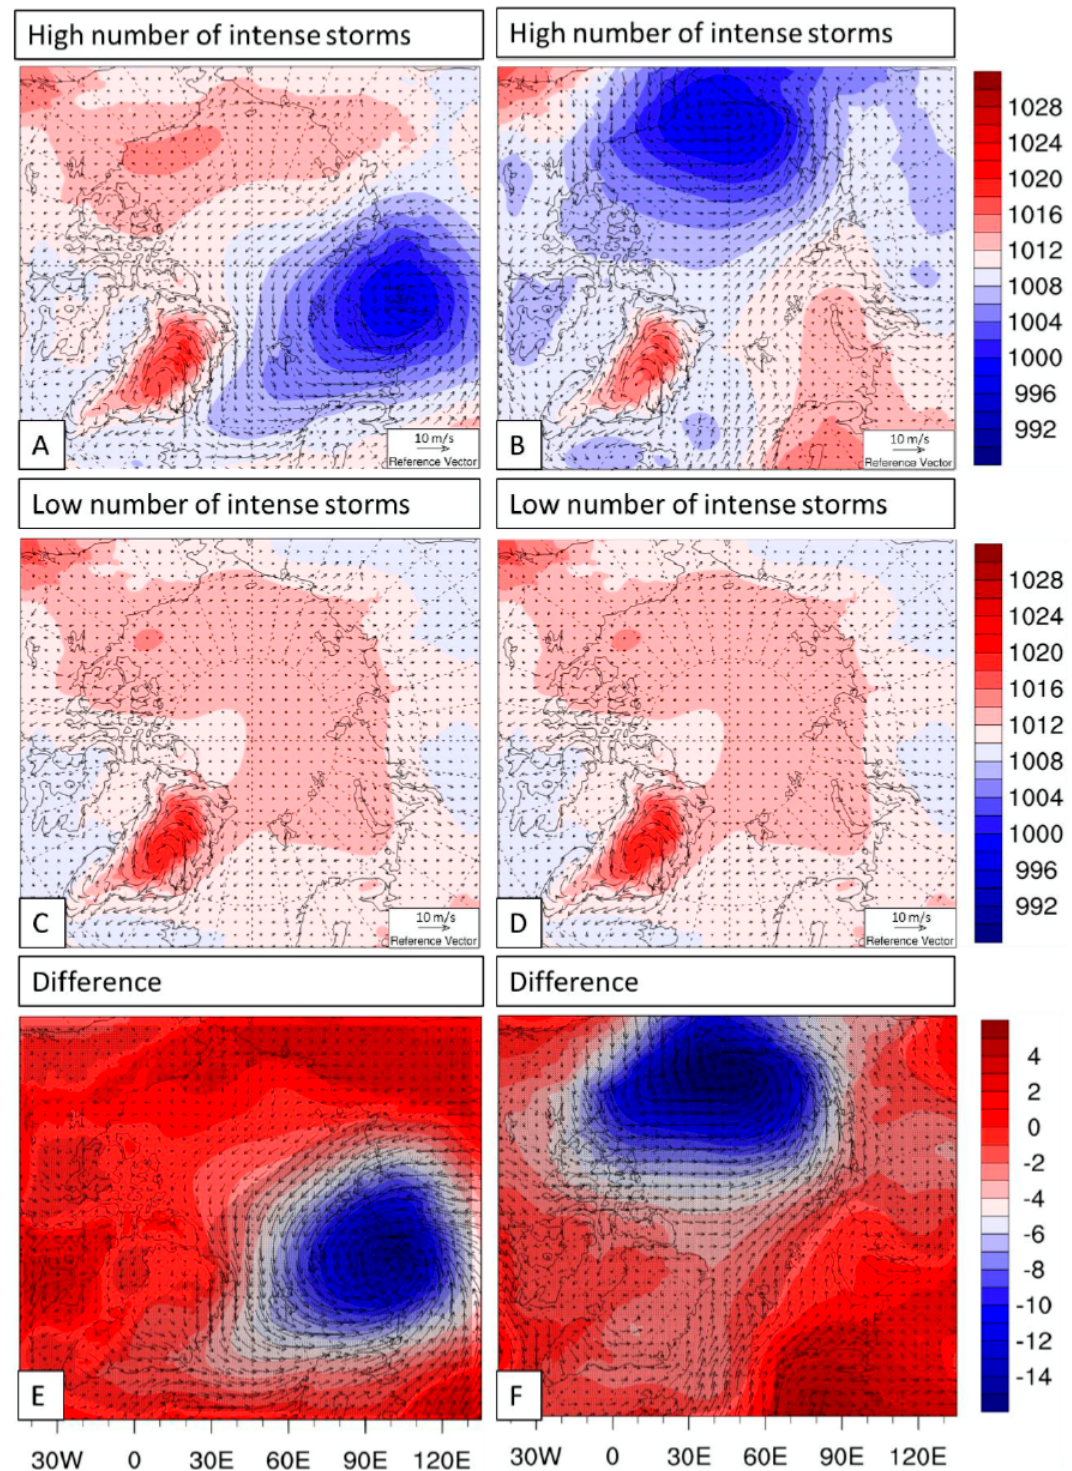
Figure 4. The composite analysis of sea level pressure (SLP; color shading) and near-surface wind (arrows) when the anomalously high count of the summer intense storms occurs over ( a ) the Atlantic Arctic Ocean; and ( b ) the Pacific Arctic Ocean, respectively, from 1948–2008. ( c , d ) are the same as ( a , b ) but for the anomalously low count of the summer intense storms. ( e , f ) show the di ff erences between ( a , c ) and between ( b , d ), respectively. Units: hPa for SLP and m / s for wind. The di ff erences at a confidence level of 95% are dotted.